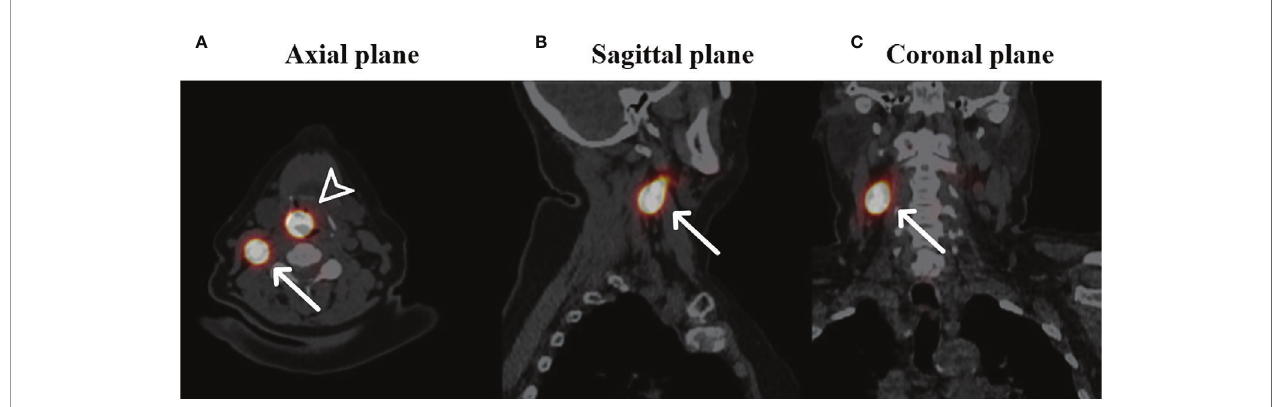
FIGURE 2 | Fused SPECT-CT images of a patient with a cT1N0 squamous cell carcinoma located on the laryngeal side of the epiglottis who underwent SN identi fi cation (own unpublished data). Arrowhead: primary injection site of 99m Tc radioisotope, white arrows: identi fi ed SN in level II on the right side in the axial plane (A) , sagittal plane (B) and coronal plane